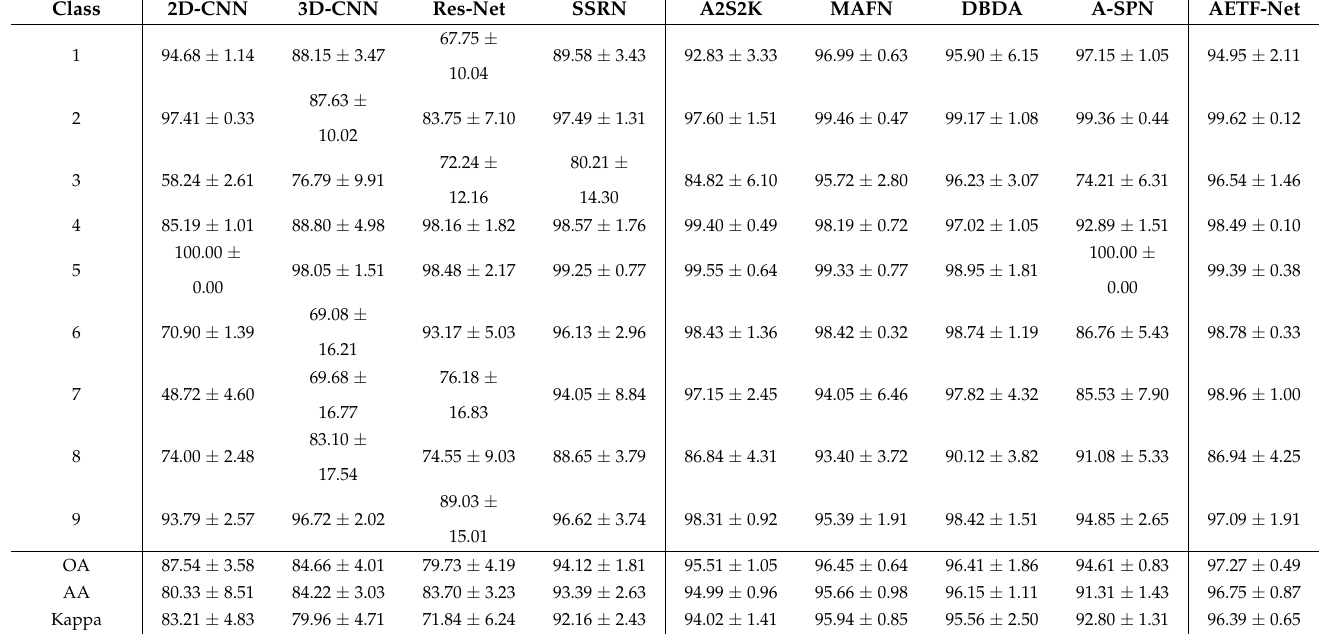
Table 6. The classification results (%) of all compared methods on the UP